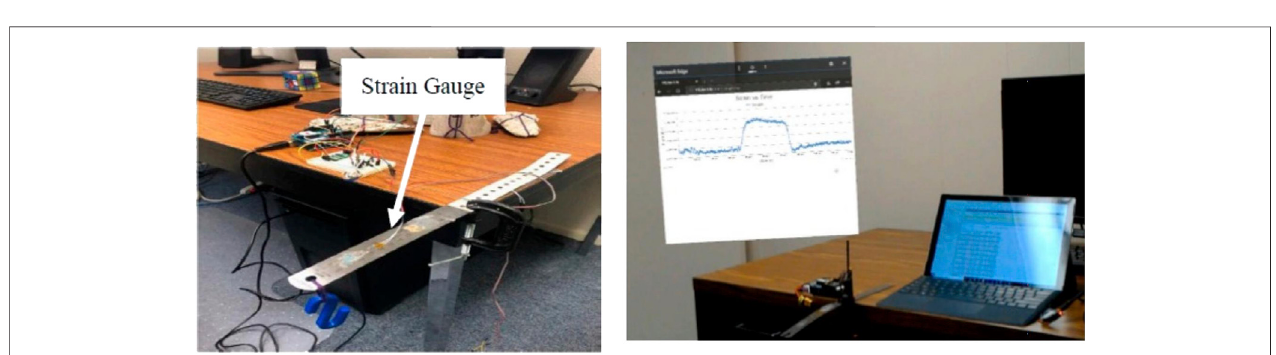
FIGURE 7 | Experiments of connection between AR devices and sensors (Aguero et al., 2020).